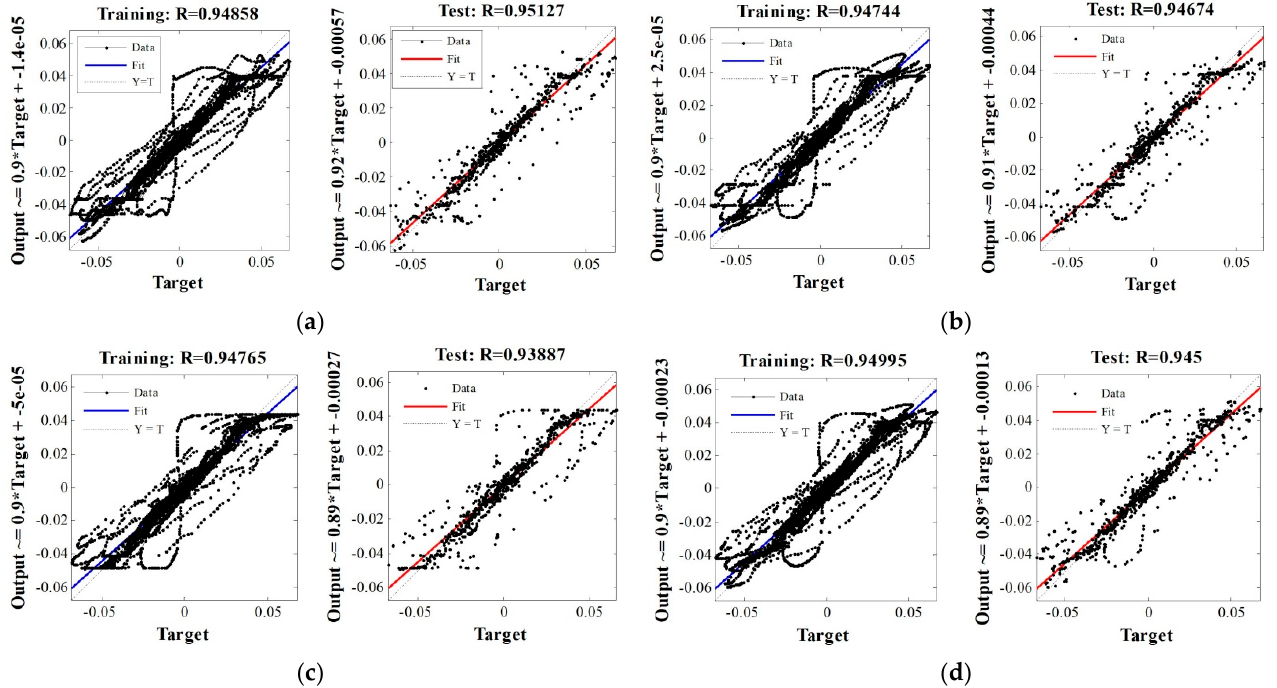
Figure 6. Pattern recognition-based regression diagram for cascaded forward backdrop using ( a ) Bayesian Regula- tion, ( b ) Polak-Ribiere Restarts, ( c ) Gradient Descent with momentum and adaptive learning rate, and ( d ) Levenberg- Marquardt